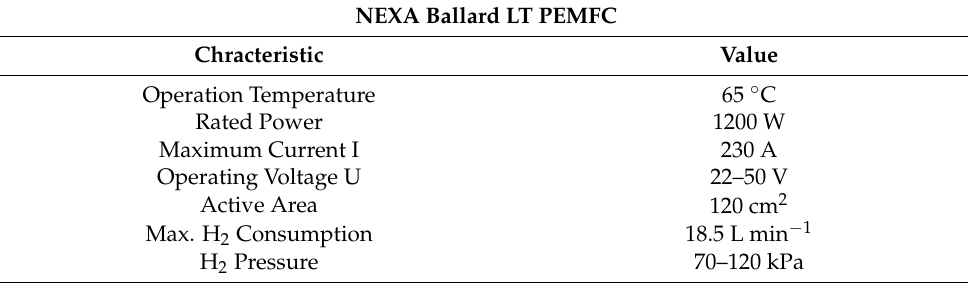
Table 1. The main working parameters of fuel cells and hydrogen storage system [39].